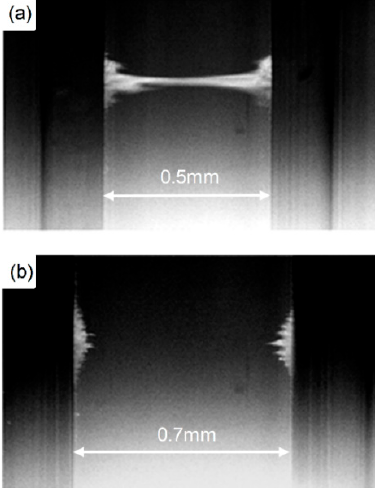
Figure 7. Experimental demonstration of the working distance in a system of two electromagnets with parabolic pole tips ( 𝛽 = 0.65 ) that are positioned 4 mm opposite each other. ( a ) Magnetic beads can be manipulated from side to side in a 0.5 mm wide glass cuvette. ( b ) Magnetic beads cannot be manipulated from side to side in a 0.7 mm wide glass cuvette.